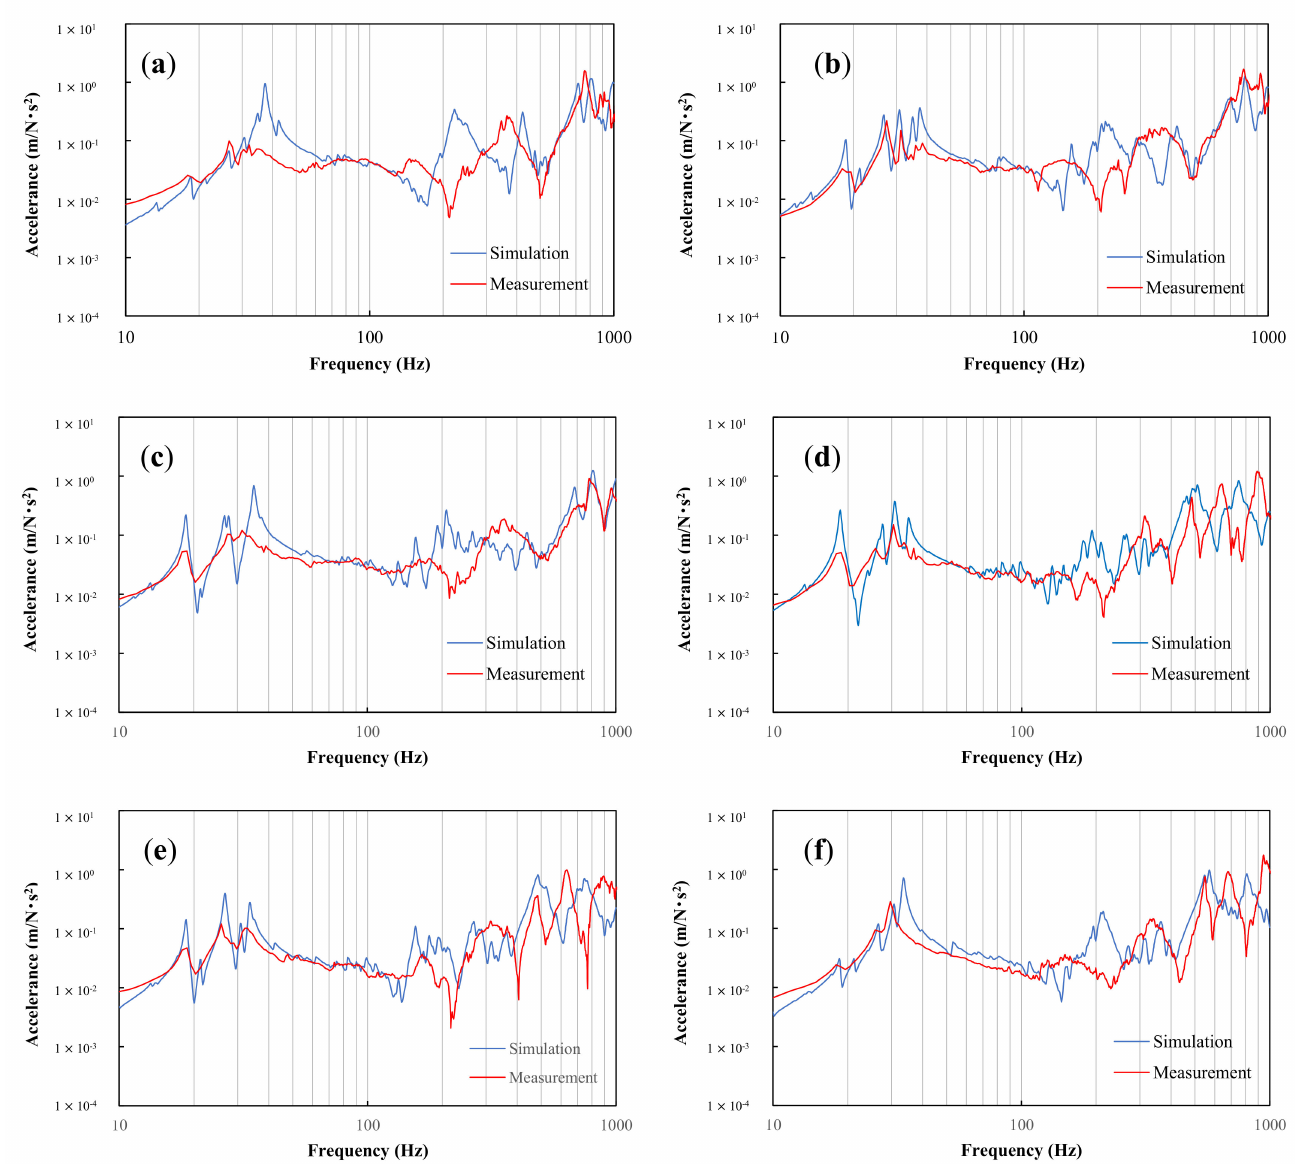
Figure 5. Comparisons of measurement and simulation results at six measurement points: ( a ) A 50 , ( b ) B 50 , ( c ) C 50 , ( d ) D 50 , ( e ) E 50 , and ( f ) F 50